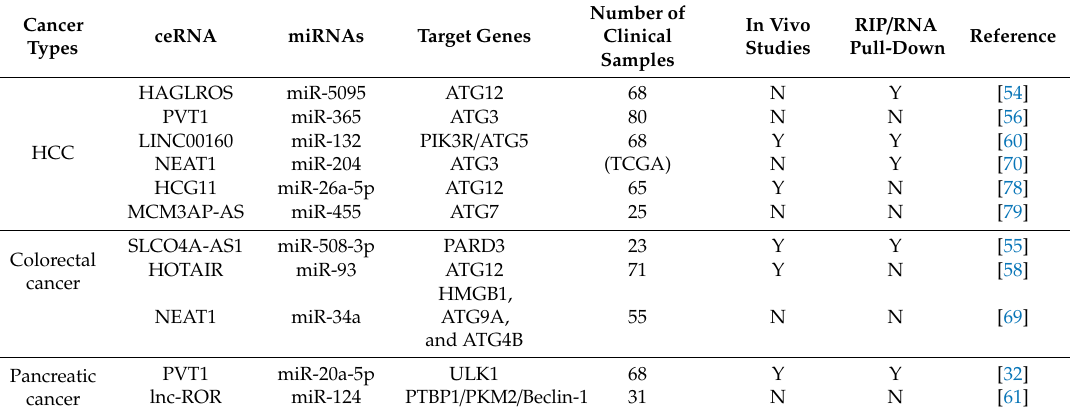
Table 2. ceRNAs regulate autophagy in HCC, colorectal cancer, and pancreatic